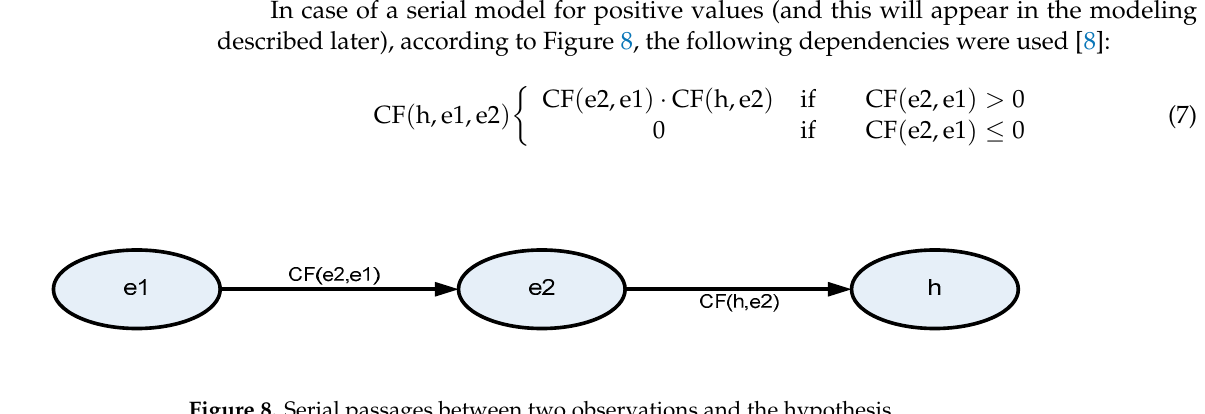
Figure 8. Serial passages between two observations and the hypothesis.